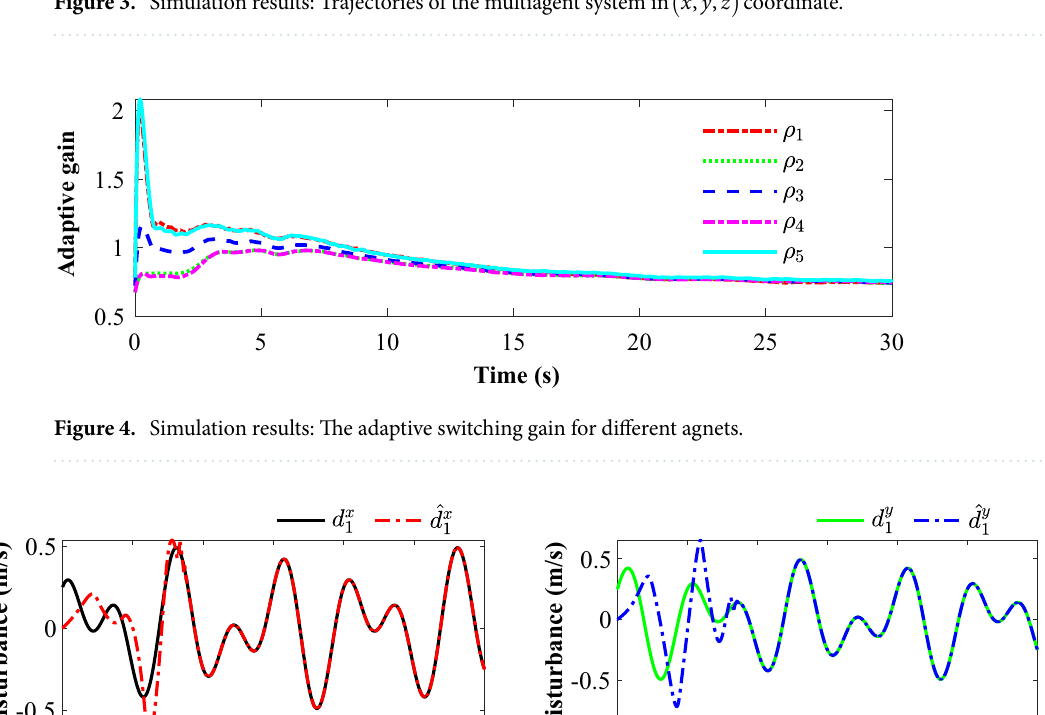
Figure 3. Simulation results: Trajectories of the multiagent system in